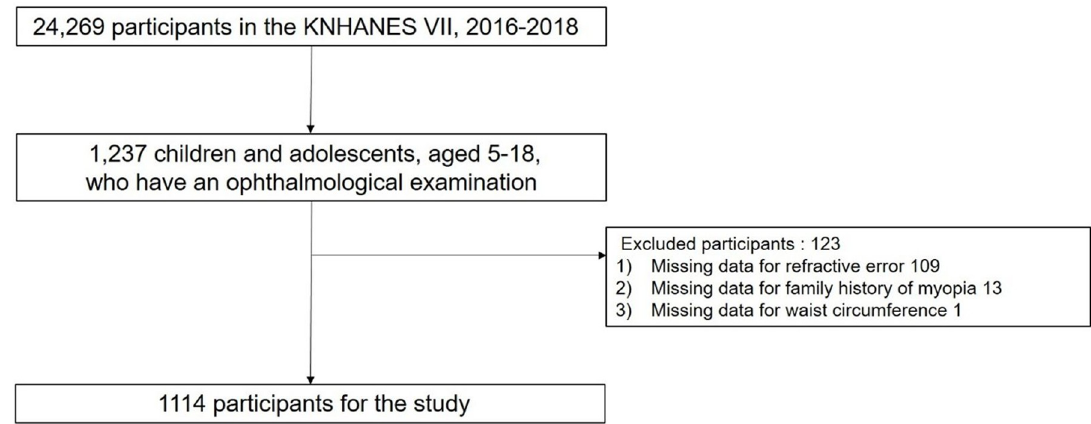
Fig 1. Study population for the study. Of total of 24269 individuals participated in KNHANES VII, 1114 were included in the analysis.